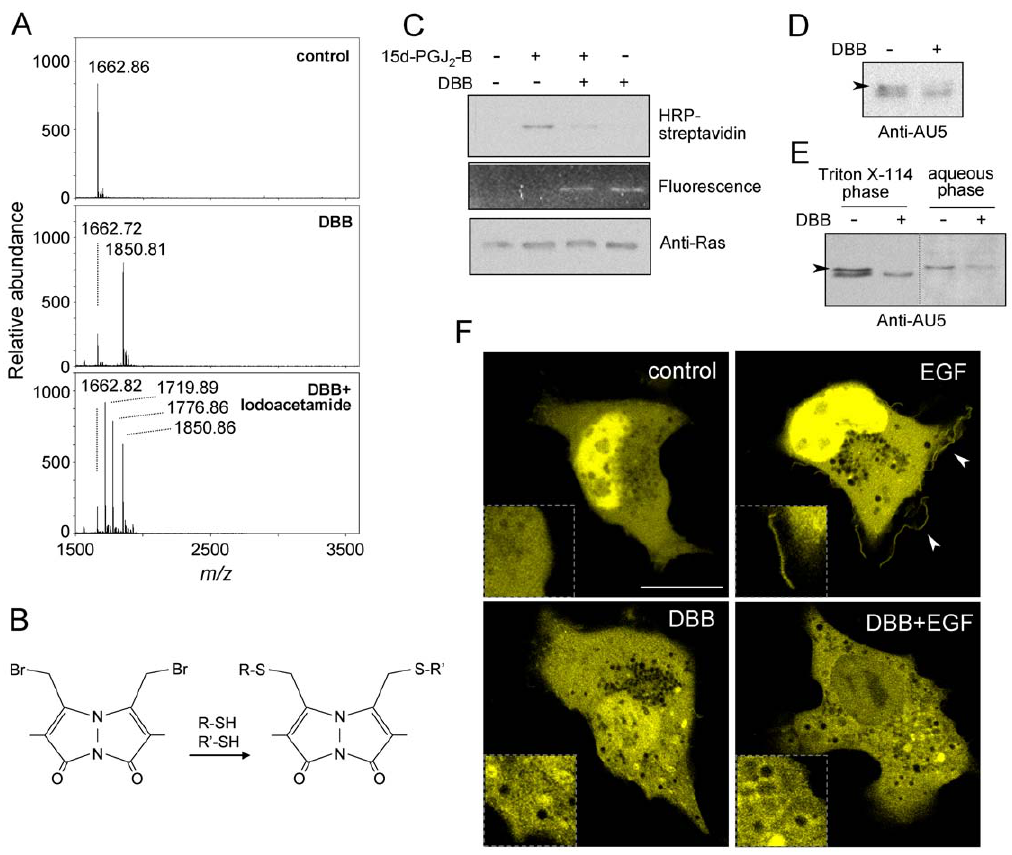
Figure 7. Interaction of the bifunctional reagent DBB with H-Ras. (A) Modification of the K170-K185 peptide by DBB. The K170-K185 peptide was incubated with DBB, as described in the Methods section. When indicated the incubation mixture was subjected to reduction and alkylation with iodoacetamide to modify free cysteines. Results are representative of three independent assays. (B) Scheme of the cross-linking of two thiol groups by DBB. (C) Competition of 15d-PGJ 2 -B binding to H-Ras by DBB. H-Ras at 5 m M was incubated with 50 m M DBB for 30 min before addition of 1 m M 15d-PGJ 2 -B for 1 h. Incorporation of the biotinylated PG was assessed by SDS-PAGE, protein blot and detection with horseradish peroxidase (HRP)- streptavidin (upper panel). Incorporation of DBB (middle panel) and total H-Ras levels (lower panel) were assessed by fluorescence detection and western blot with anti-pan Ras antibody, respectively. (D) COS-7 cells transfected with the AU5-H-Ras vector were treated in the absence or presence of 50 m M DBB for 1 h. Aliquots from total cell lysates (10 m g of protein) were analyzed by SDS-PAGE. The upper component of the AU5-H-Ras doublet is indicated by an arrowhead. (E) COS-7 cells transfected with the AU5-H-Ras vector were treated with DBB and subjected to fractionation in Triton- X114 as above. In (D) and (E) levels of AU5-H-Ras were assessed by western blot with anti-AU5 antibody. The dotted line marks where lanes from the same gel have been cropped. (F) COS-7 cells transfected with YFP-RBD as above were treated with 50 m M DBB for 1 h before stimulation with 100 nM EGF, as indicated, and visualized live by confocal fluorescence microscopy. Dotted inserts show enlarged areas from the same cells for better visualization. Arrowheads mark the accumulation of YFP-RBD at defined locations of the cell periphery. Bar, 20 m m. Shown are representative images from three experiments with similar results.